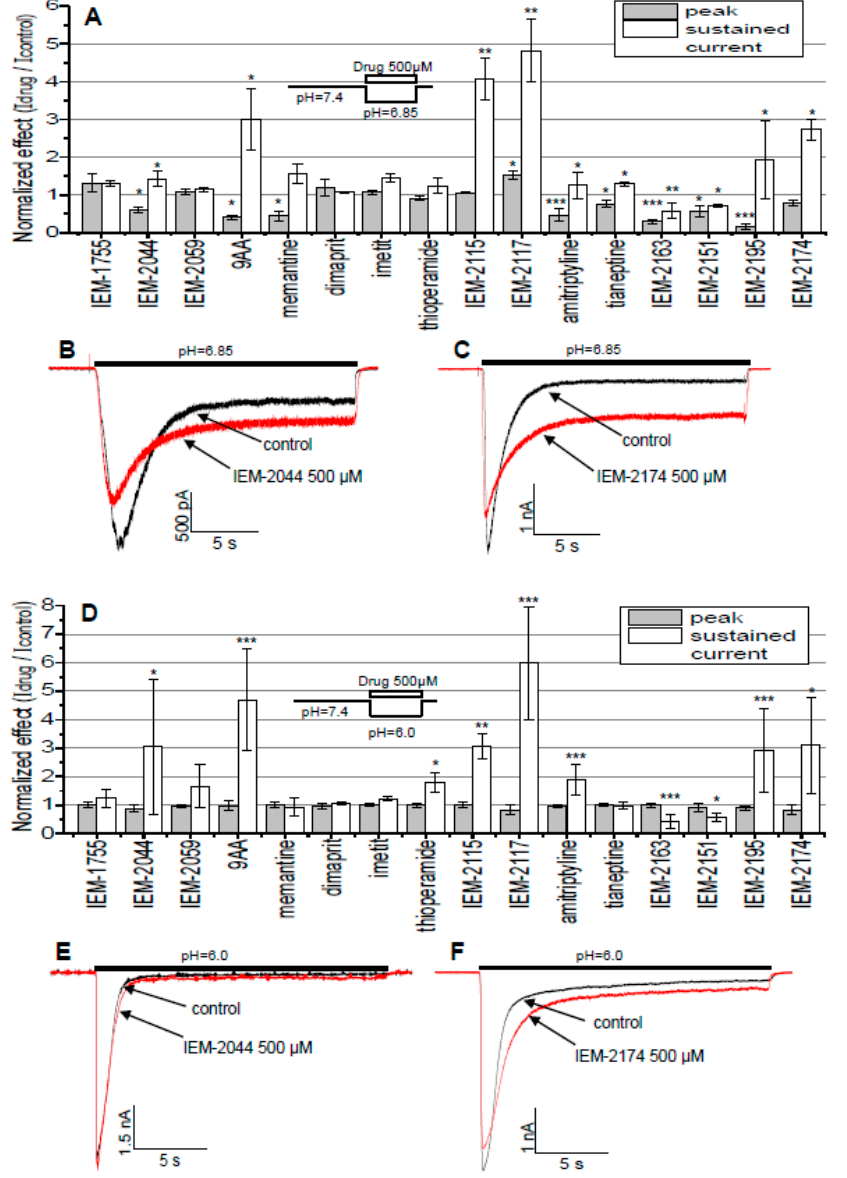
Figure 2. Estimation of the drug activities. Number of * denotes statistical significance at * p < 0.05, ** p < 0.01, or *** p < 0.001, respectively, n ≥ 5. ( A ) Effects of 500 µM of the compounds studied on the ASIC3 activated by pH drop from 7.4 to 6.85. Compounds were applied simultaneously with